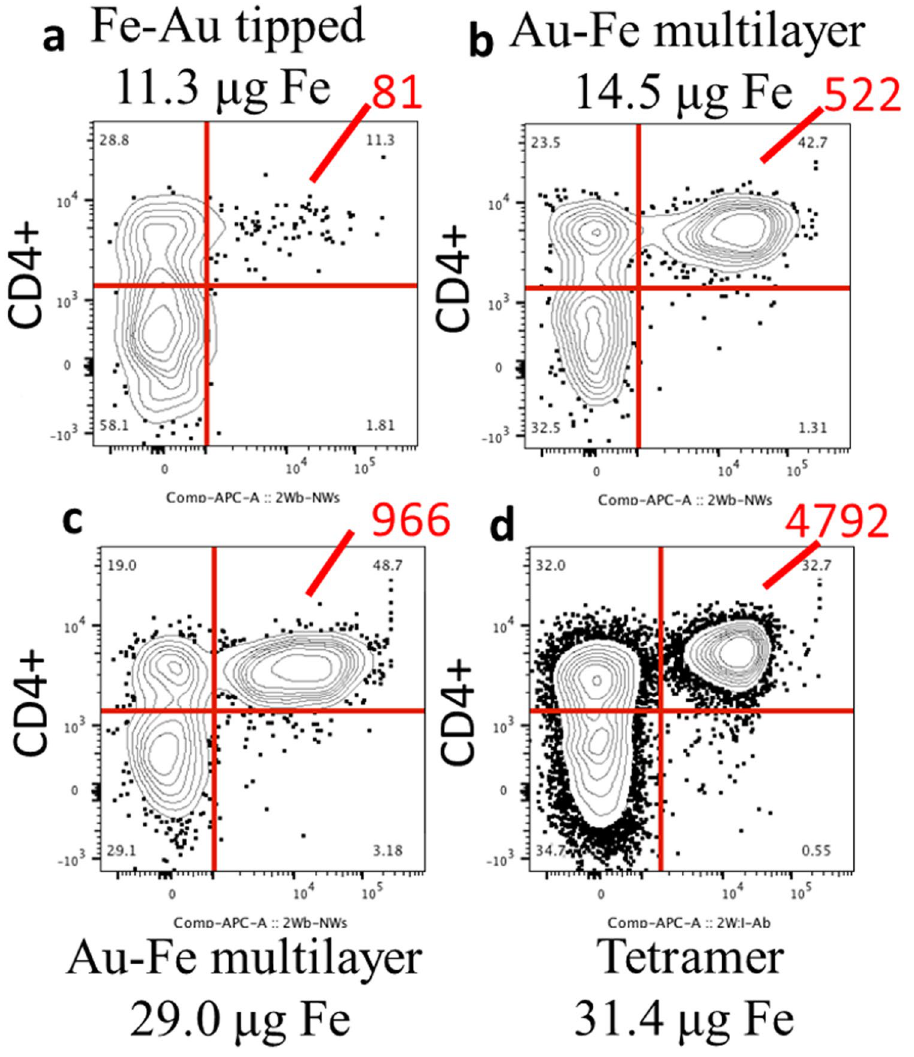
Figure 4. Flow cytometric analysis of CD4 + T lymphocytes cell suspensions after tagging and magnetic enrichment with fluorescent Au-tipped Fe nanowires ( a ) or Fe-Au multilayer nanowires ( b , c ) or conventional tetramer ( d